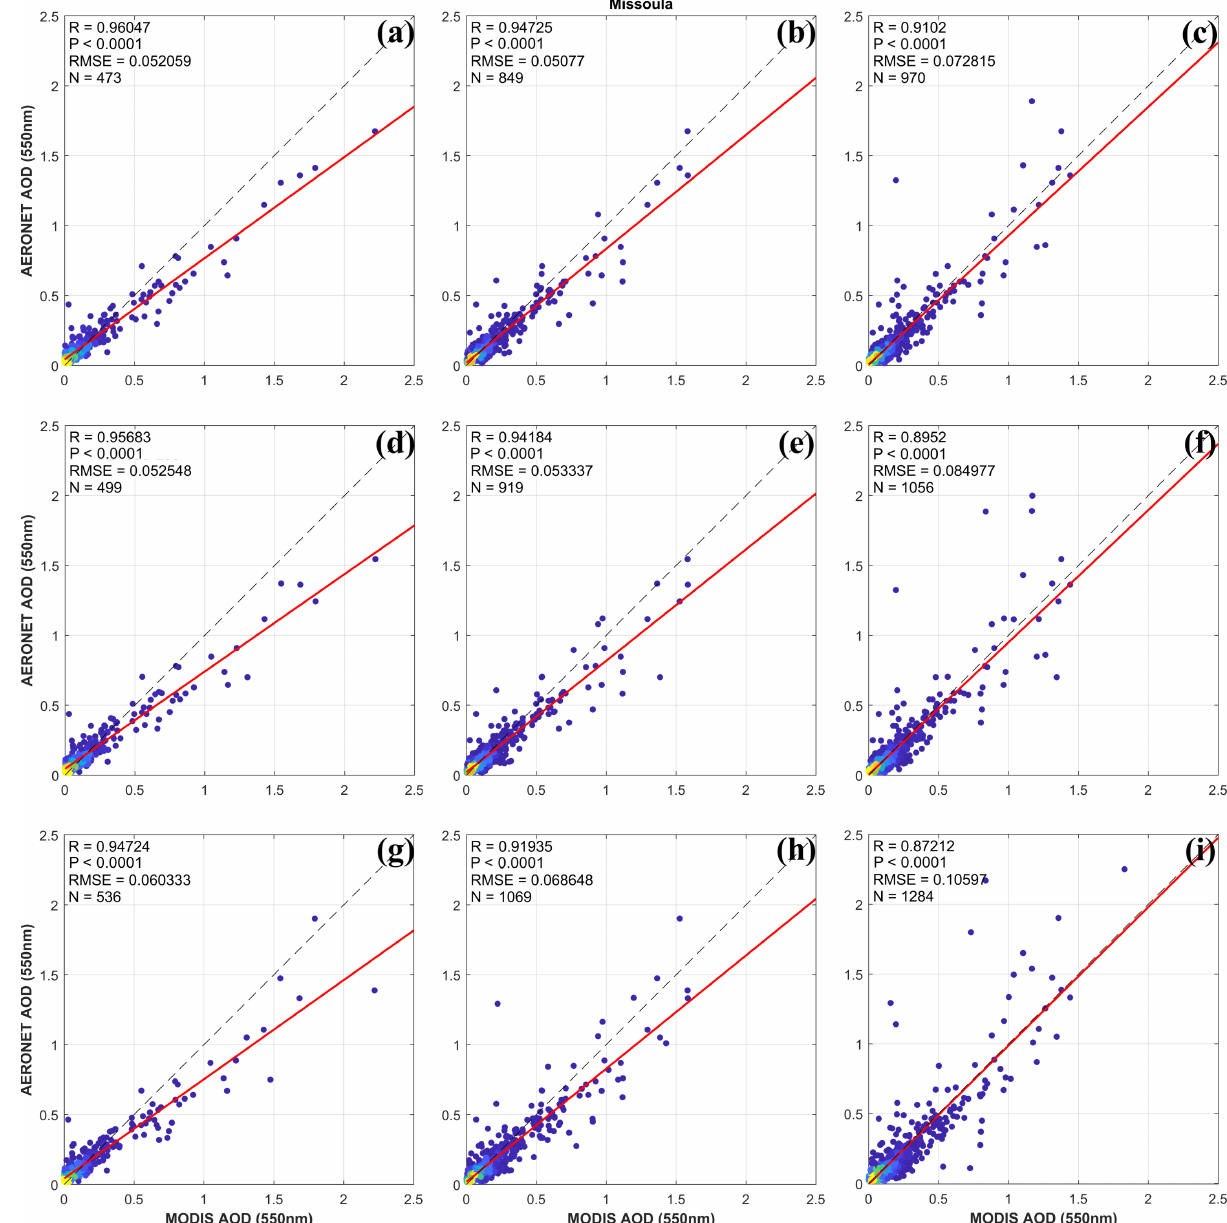
Figure 7. Scatter plots representing the validation of Aqua MODIS DT (land and ocean) AOD against AERONET AOD processed at 550 nm of the representative Missoula station: Nearest single pixel in time ( a ) nearest single pixel in space, averaged from nearest ( b ) 9 pixels, and ( c ) 25 pixels; 30 min averaging domain ( d ) nearest single pixel in time, averaged from nearest ( e ) 9 pixels, and ( f ) 25 pixels; and 3-h averaging domain ( g ) nearest single pixel in time, averaged from nearest ( h ) 9 pixels, and ( i ) 25 pixels. The red line is a regression line. Where R—Pearson correlation coefficient, P— p value, RMSE—root mean square error at 5% significance level, and N—number of matched AOD